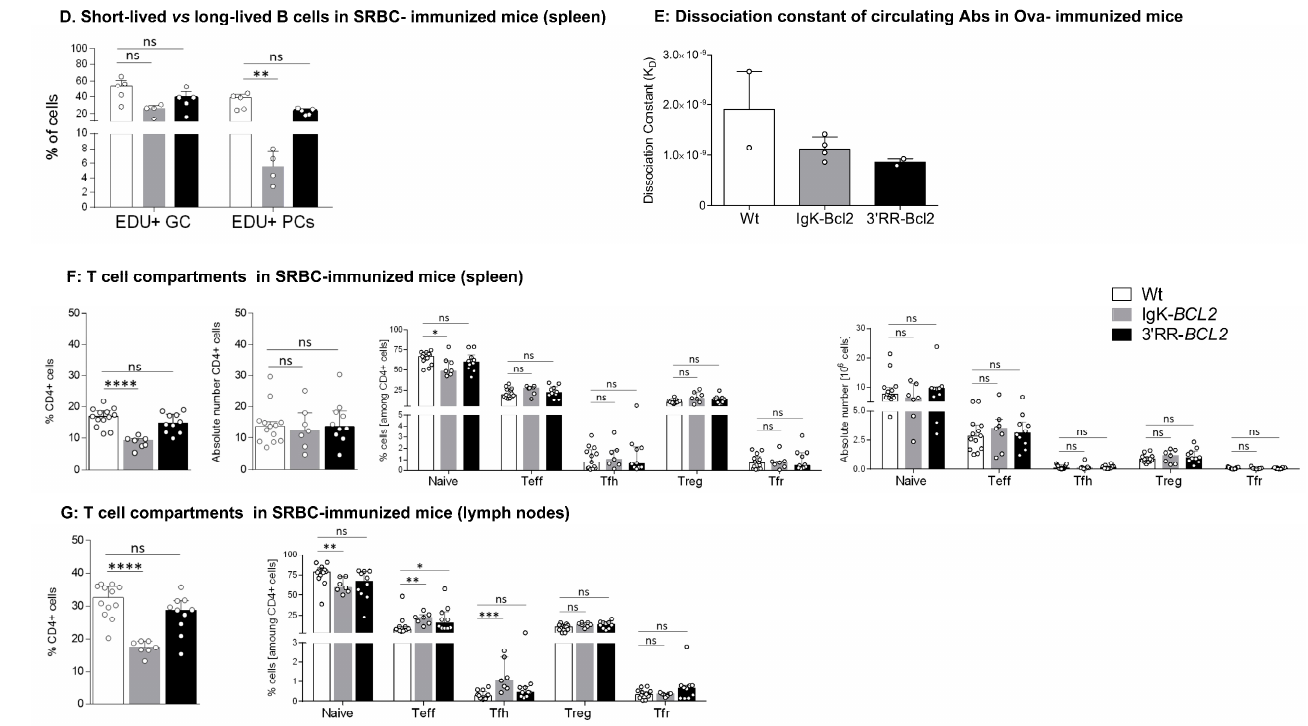
Figure 3. Immune responses in immunized mice ( A – C ) Impact of BCL2 deregulation on the immune response of immunized mice lymphoid tissues (bone marrow, spleen, and mesenteric lymph nodes, respectively), of intra-peritoneal immunization (3 iterative SRBC injections, on a monthly basis). B cells were evaluated by flow cytometry in BCL2 mice compared to WT. The ratios of centroblasts to centrocytes, as well as CD93+ / CD93- plasma cells and plasmablasts, are indicated. Percentages of the different populations, as well as absolute cell numbers (calculated based on the percentages obtained by flow cytometry and the total amount of lymphocytes in each organ), are presented as medians with interquartile range: statistical significance was determined using the Mann–Whitney U test. The full staining panel and gating strategy are summarized in Supplementary Table S1 and Supplementary Figure S1A–S1C. ( D ) Flow cytometry analysis of splenocytes stained with EDU (24 h post intraperitoneal EDU injection and 7 days after SRBC immunization) in WT (5), Ig κ -BCL2 ∆ /+ (4) and 3 ′ RR-BCL2 mice (5). The percentages of EDU-stained plasma cells (EDU+ PC) and GC B cells (EDU+ GC) are medians with interquartile range. Statistical significance was determined using Mann–Whitney U test. EDU staining was revealed by coupling to Alexa 488, together with specific markers for plasma cells (CD138 BV786), GC B cells (GL7-APC and CD38-APC-R700), and cell viability (FVS 780). ( E ) Affinity of anti-Ova antibodies. Histogram of the dissociation constant (KD) of IgG to Ova, evaluated by ELISA, in the sera of BCL2 mice compared to WT. Lower KD marks a higher affinity for Ova. KD values are medians with interquartile range. ( F , G ) Flow cytometry data showing the impact of the BCL2 deregulation accompanied with 3 iterative intra-peritoneal SRBC injections (on a monthly basis) on the different T cell populations, in both BCL2 mouse models compared to WT, in the periphery (spleen and LNs). Both percentages and absolute cell numbers of each T cell population are presented as medians with interquartile range, and the statistical significance is realized via the Mann–Whitney U test. (* p<0.05; ** p<0.01; *** p<0.001; **** p<0.0001). In BM (Figure 3A), the B-cell increase corresponded to recirculating B-cells, whereas all B-cell progenitor compartments appeared to be decreased. Percentages and the abso- BCL2 mice.